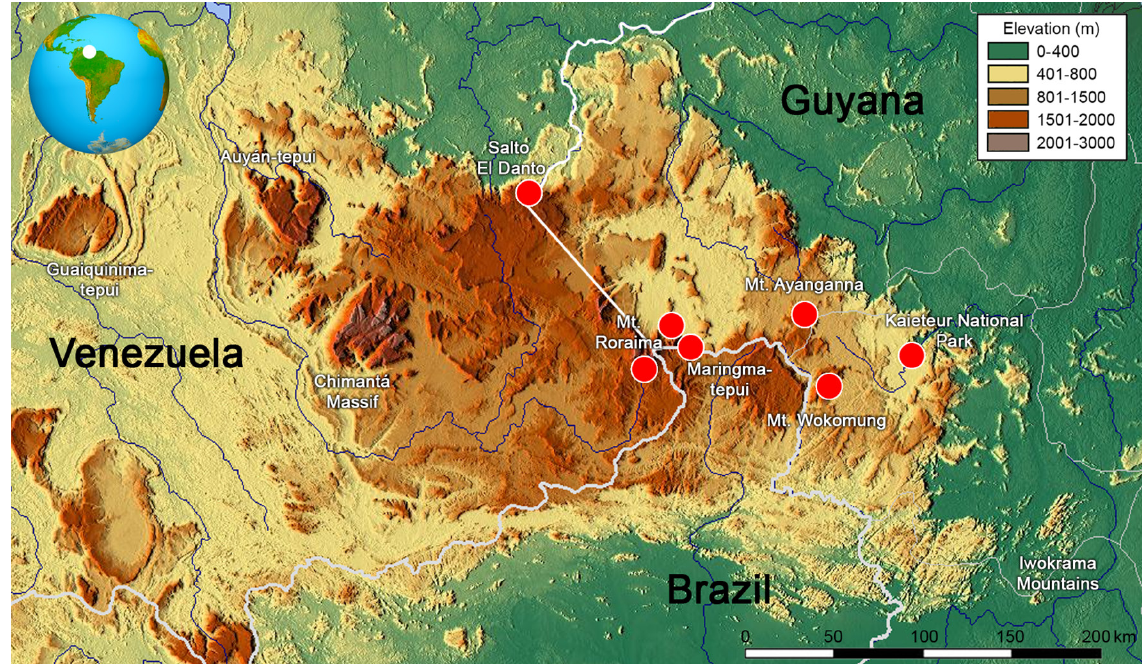
Fig. 1. Map of the Eastern Pantepui District showing the known distribution of Pristimantis marmoratus (Boulenger, 1900). Red dots denote localities of confirmed occurrence based either on museum specimens or colour